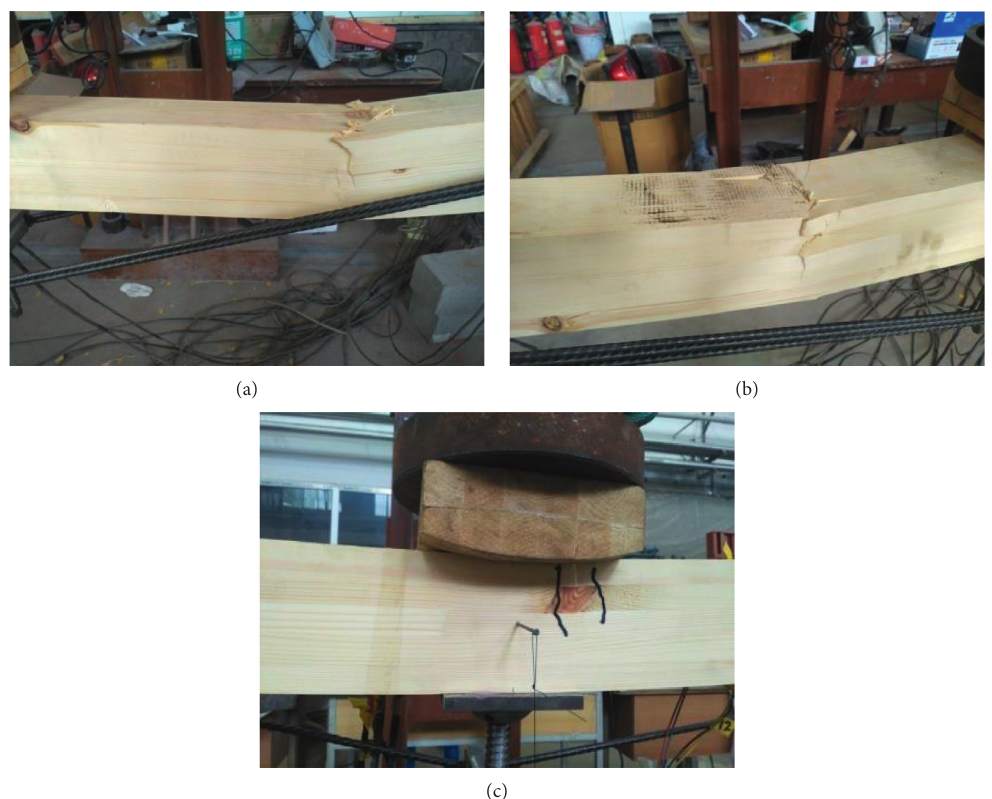
2(2) right span. (b) Wrinkling on top of the LA 3(2) right span.